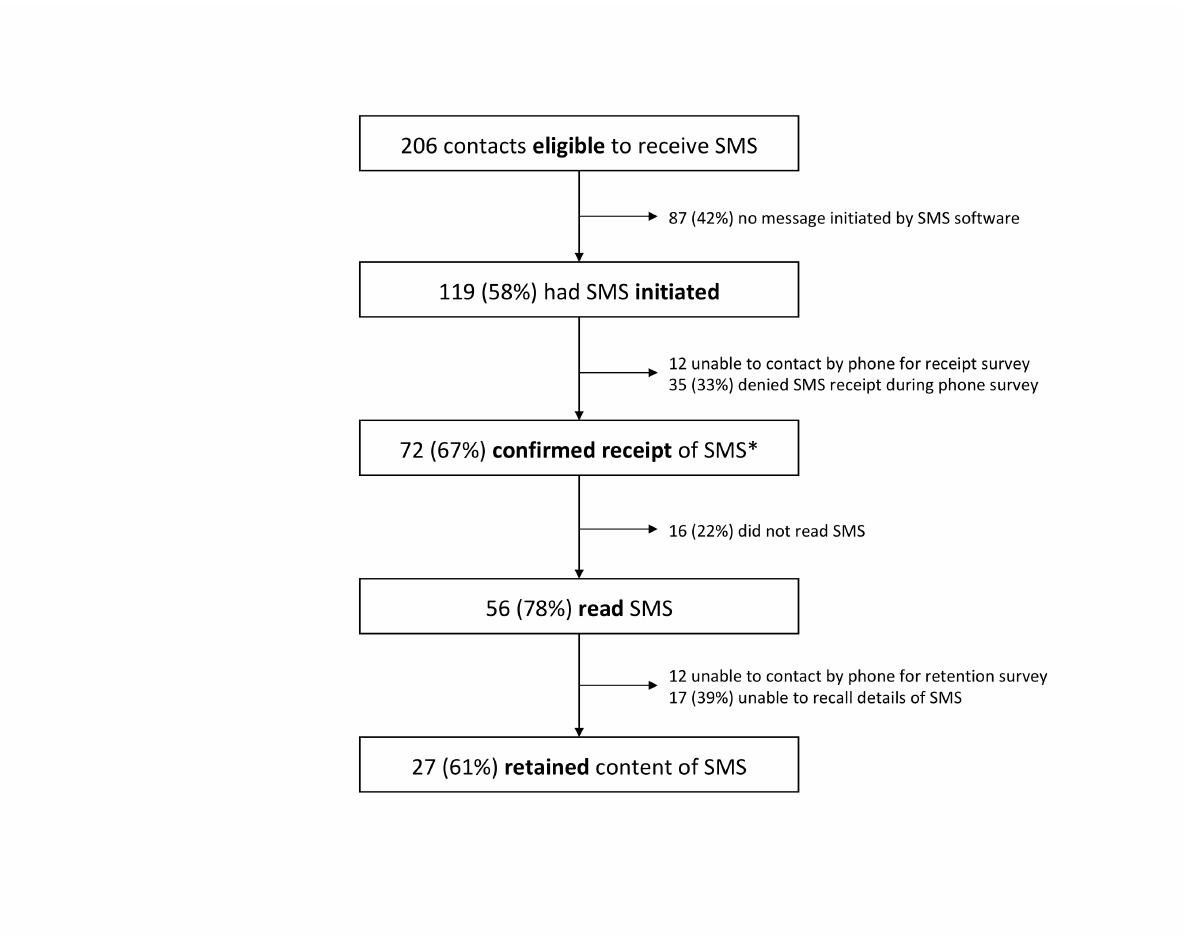
Figure 2. Flow diagram showing process measures for short message service (SMS) delivery. *24 participants confirmed receipt by reply SMS and an additional 48 confirmed receipt during the telephone survey.